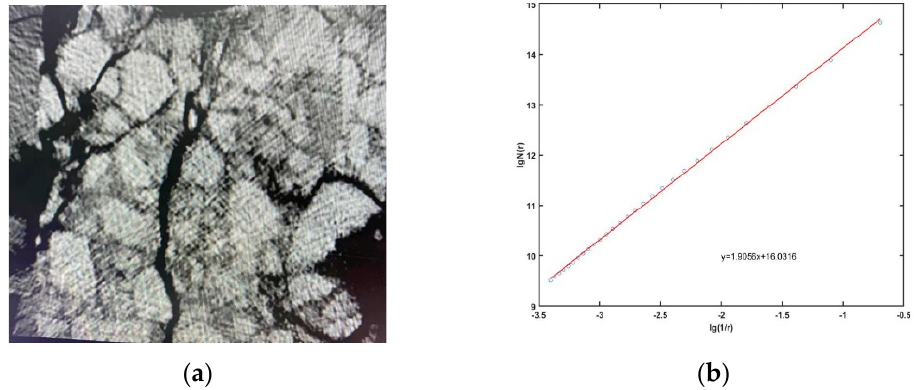
Figure 18. The damage picture of the center of the arch by impact (40 kg) and burning ( a ); the fractual curve ( b